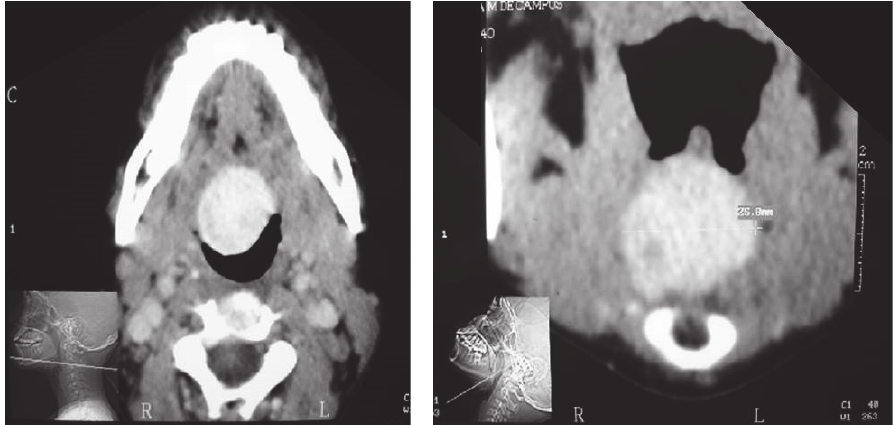
Figure 2: CT scan shows in axial cut a well defined hyperdense image of approximately 25.8 mm at its largest diameter, with infiltrative growth in the posterior region of the base of the tongue.